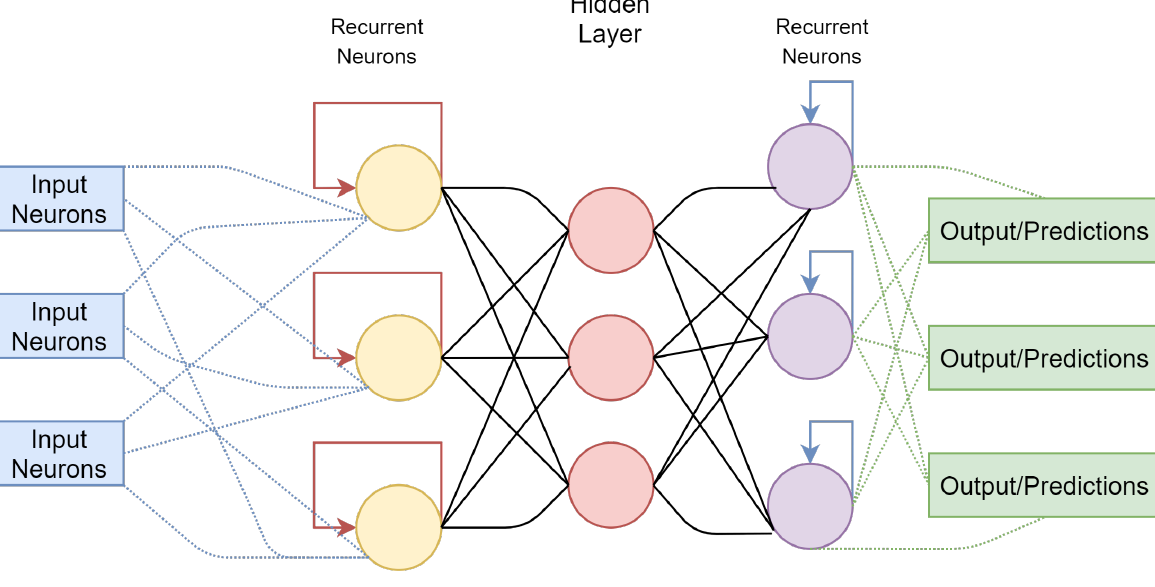
Figure A1. Basic Structure of a